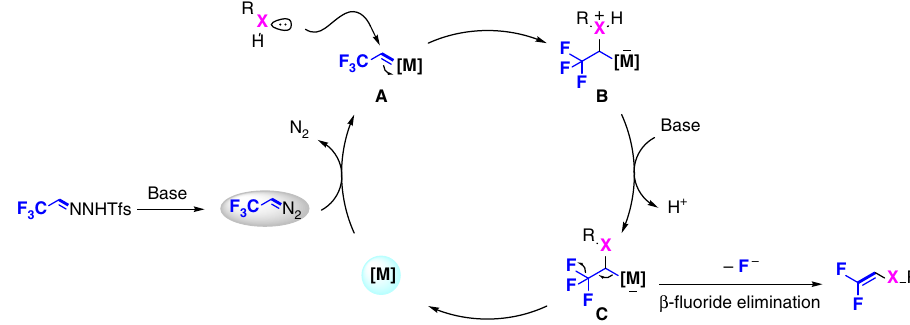
Fig. 6 Proposed mechanism. Mechanistic insights regarding to formation of oxonium ylide and fl uoride elimination